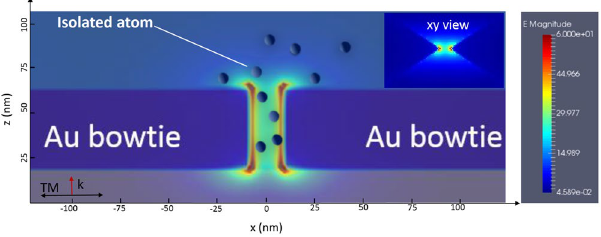
Figure 1. XZ plane representation of the plasmonic field enhancement from two gold nano-antennas. The XY representation is shown as an inset. The field enhancement is calculated using FTDT approach at a laser wavelength of 825 nm. Atoms are sketched as spheres immersed in the field enhanced by the two antennas. The field is polarized along the TM axis and propagates along the k